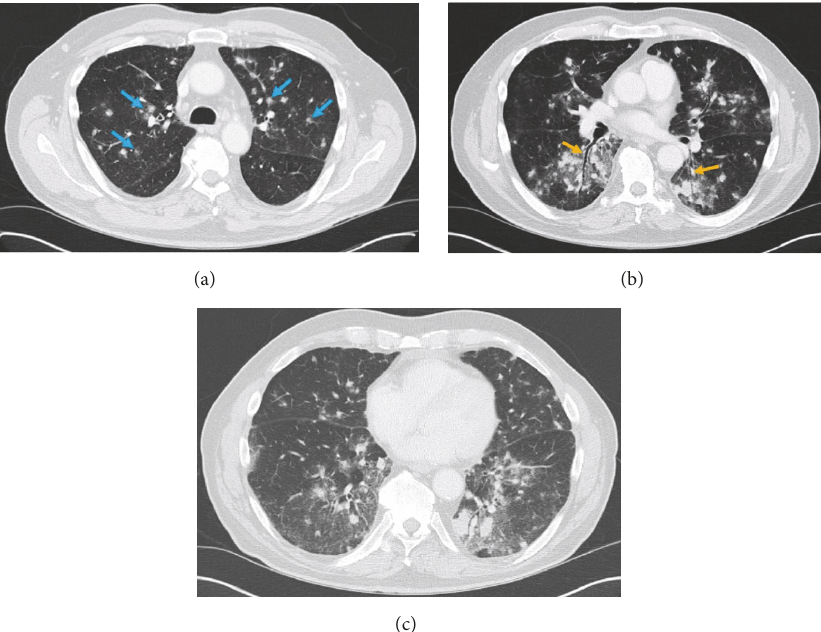
Figure 1: Axial lung window CT slices (a, b, c) at different levels demonstrate innumerable ill-defined solid nodules with peripheral ground- glass halos in a peribronchovascular distribution (blue arrows) and more prominent in the left lung. Air-bronchograms were seen (orange